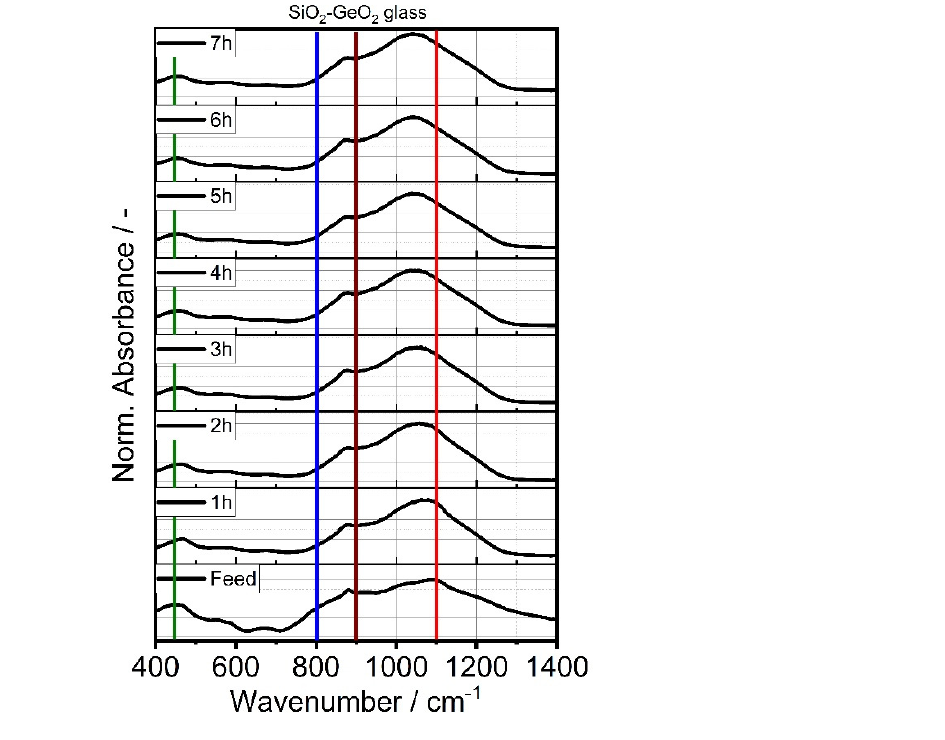
Figure 5. IR spectra evolution of the mixed SiO 2 ‐ GeO 2 glass with increasing comminution time. The colored lines correspond to the absorption bands displayed in Table 6.